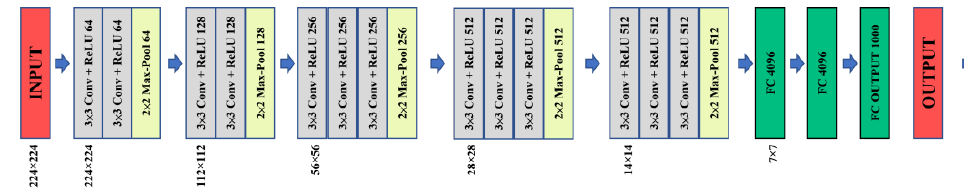
Figure 5. VGG16 architecture.